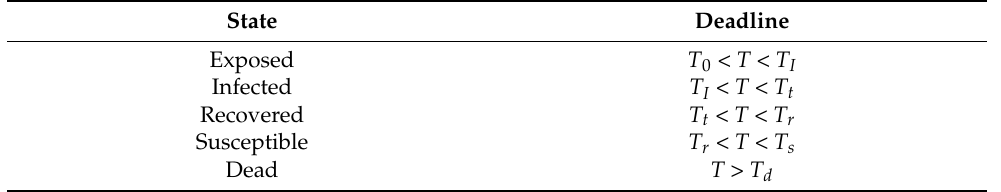
Table 2. Deadlines in the DD_model.